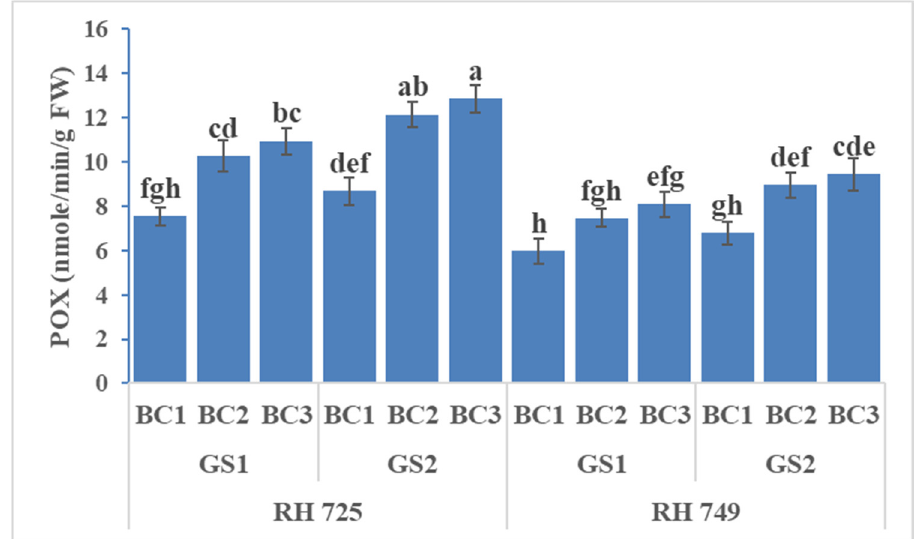
Figure 8. Comparisons of the effects of different concentrations of brassinolide sprays (BC1: control (water spray); BC2: 10 mg BRs/L water; BC3: 20 mg BRs/L water) on the peroxidase (POX) activity of drought-tolerant (RH 725) and drought-sensitive (RH 749) Indian mustard cultivars at the flower initiation (GS1) and 50% flowering (GS2) stages. Columns marked by different letters indicate significant differences ( p < 0.05) between treatments based on Duncan’s multiple range test. Error bars denote the standard errors of the mean.